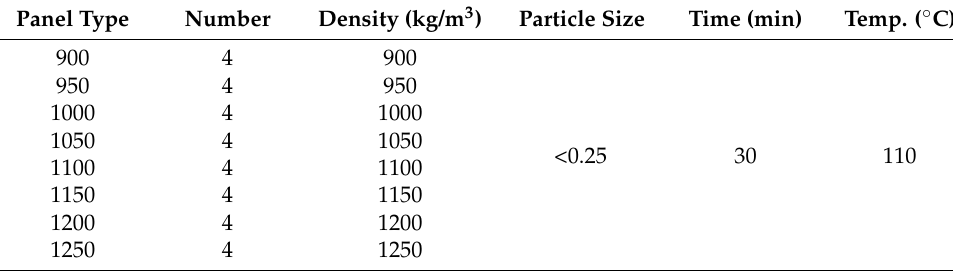
Table 1. Characteristics of the experimental